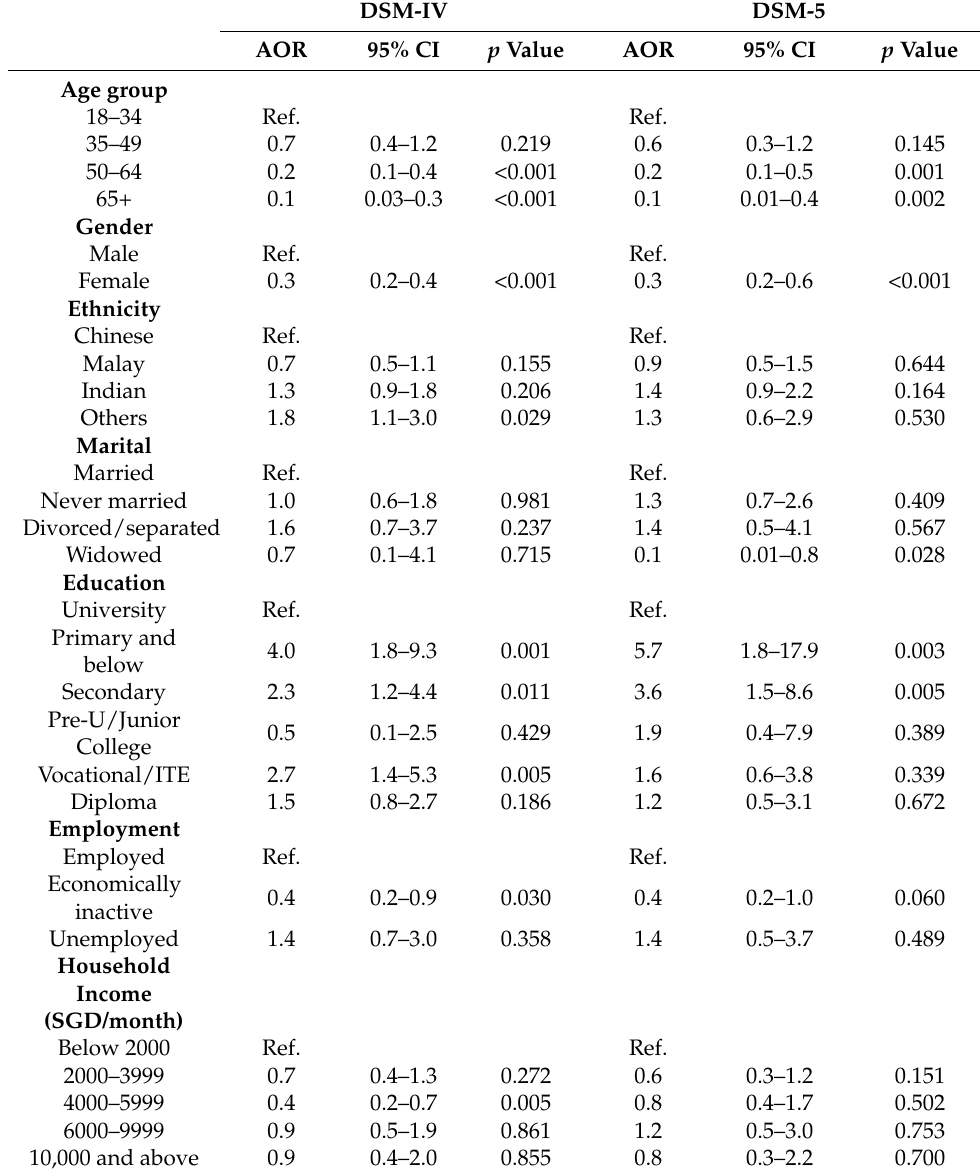
Table 3. Sociodemographic correlates of lifetime DSM-IV and DSM-5 alcohol use